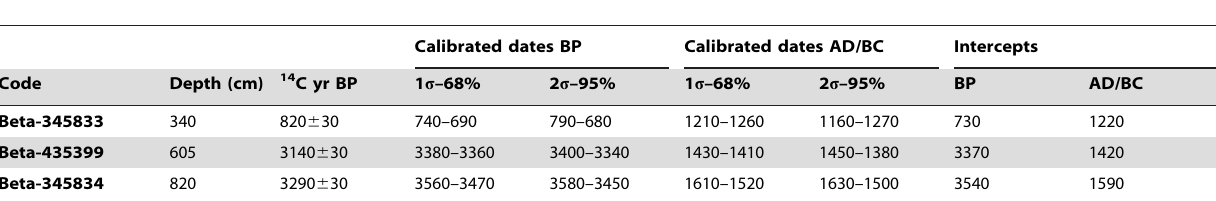
Table 1. Details of the 14 C age determinations for the core B 22